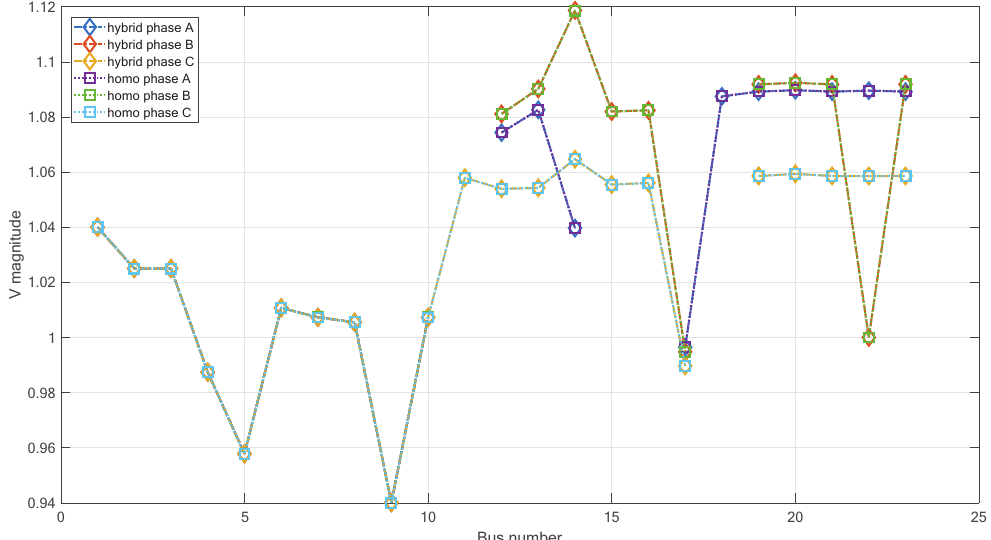
Figure 6. Per-unit voltage profile of the three phases of the master–slave hybrid and homo splitting methods. The represented network is the T9-D13